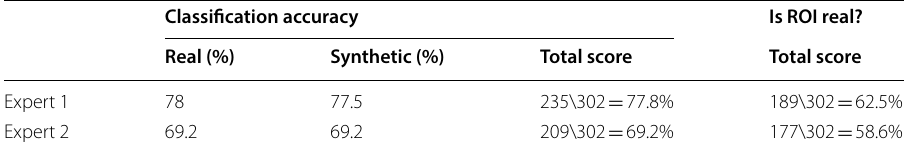
Table 5 Results of ‘Visual Turing Test’ on DCGAN-generated liver lesion images presented by Frid-Adar et al. [139] Classification accuracy Is ROI real?